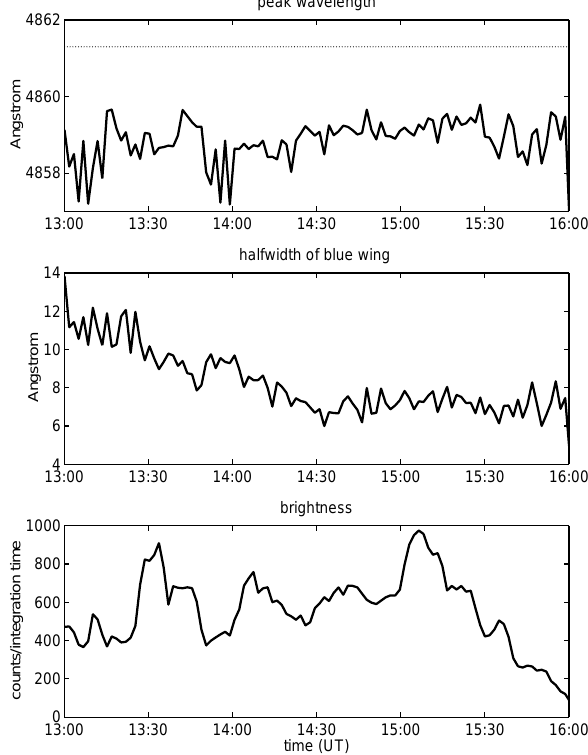
Fig. 14. Variations in fitted paramaters of profiles: (top) peak wave- length, (middle) width of blue wing and (bottom) intensity in counts per